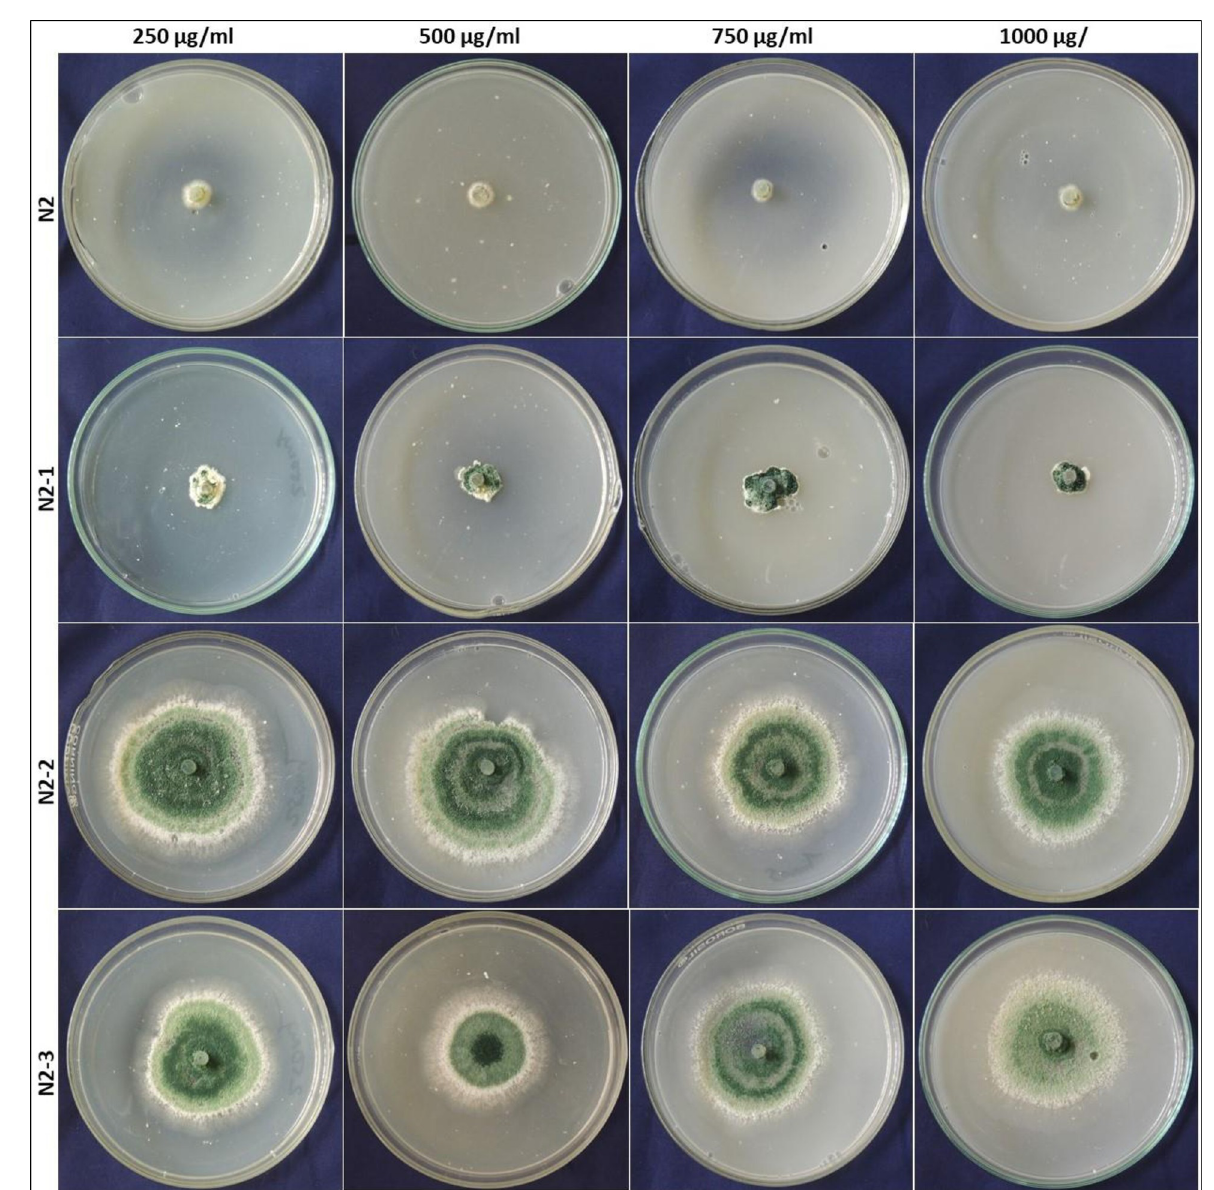
Fig 1. Carbendazim tolerance in N-methyl-n-nitro-N-nitrosoguanidine irradiated Trichoderma mutants. Mutants N2-1, N2-2, N2-3 is compared with N2 mutant at carbendazim 250, 500, 750 and 1000 μ g/ml in PDA plates, and observation are recorded when the control plates cover the whole